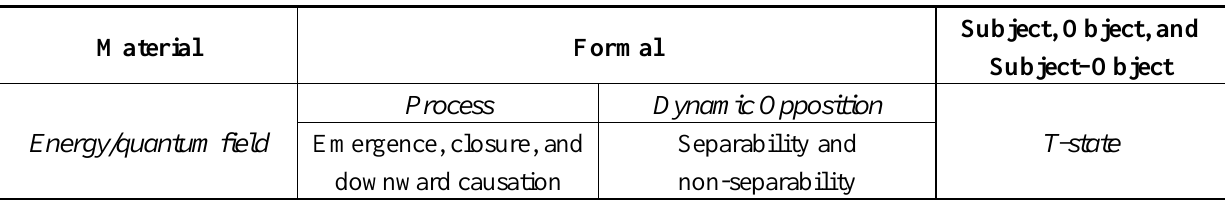
Table 1. Categories of